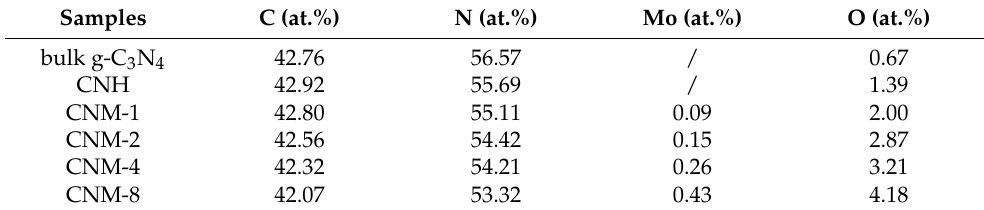
Table 1. Elemental compositions of each